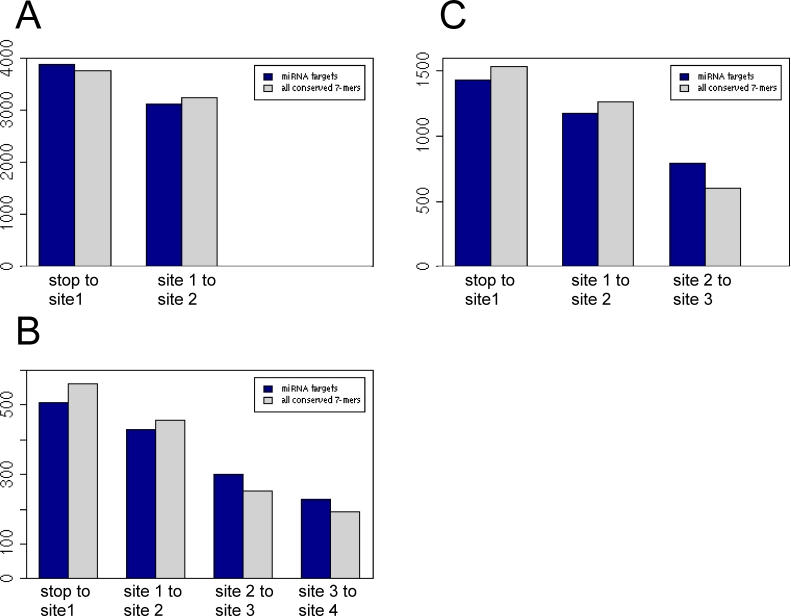
Distribution of Putative miRNA Targets and Other Conserved 7-mers in 3′ UTR Segments Delimited by Alternative Poly(A) SitesNumber of putative miRNA targets is in dark blue, and total number of conserved 7-mers in gray, scaled down so that total 7-mers equals total miRNA targets. (A) Genes with two poly(A) sites. (B) Genes with three poly(A) sites. (C) Genes with four poly(A) sites.